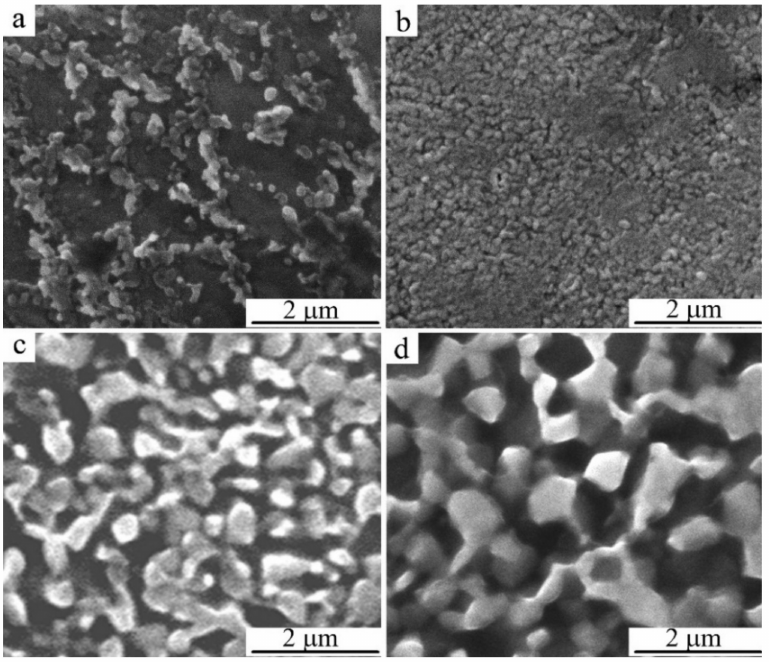
Figure 12. SEM images of the microstructure of the Cu-14Al-3Ni alloy after the HPT of 10revs and anneals for 30 min at temperatures of ( a ) 373, ( b ) 673, ( c ) 773, and ( d ) 873